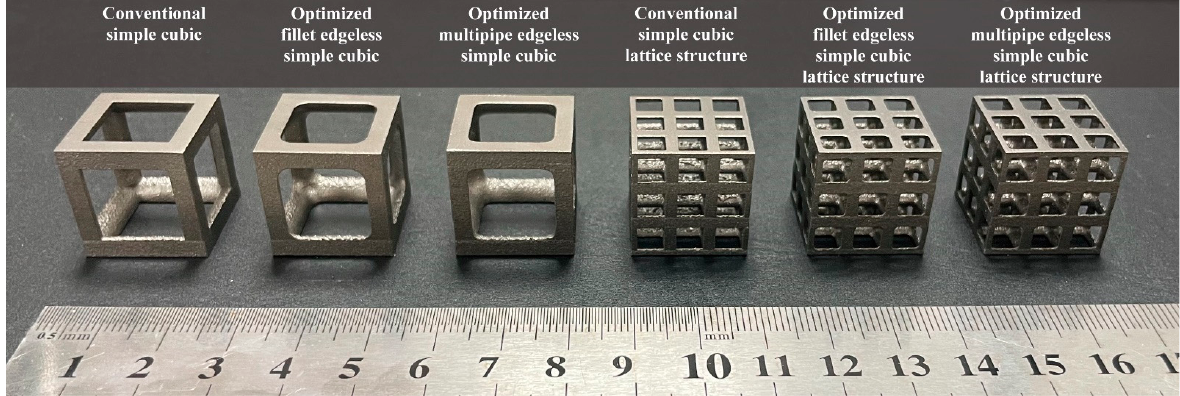
Figure 18. The additive manufactured specimens with optimized edgeless simple cubic lattice structures.